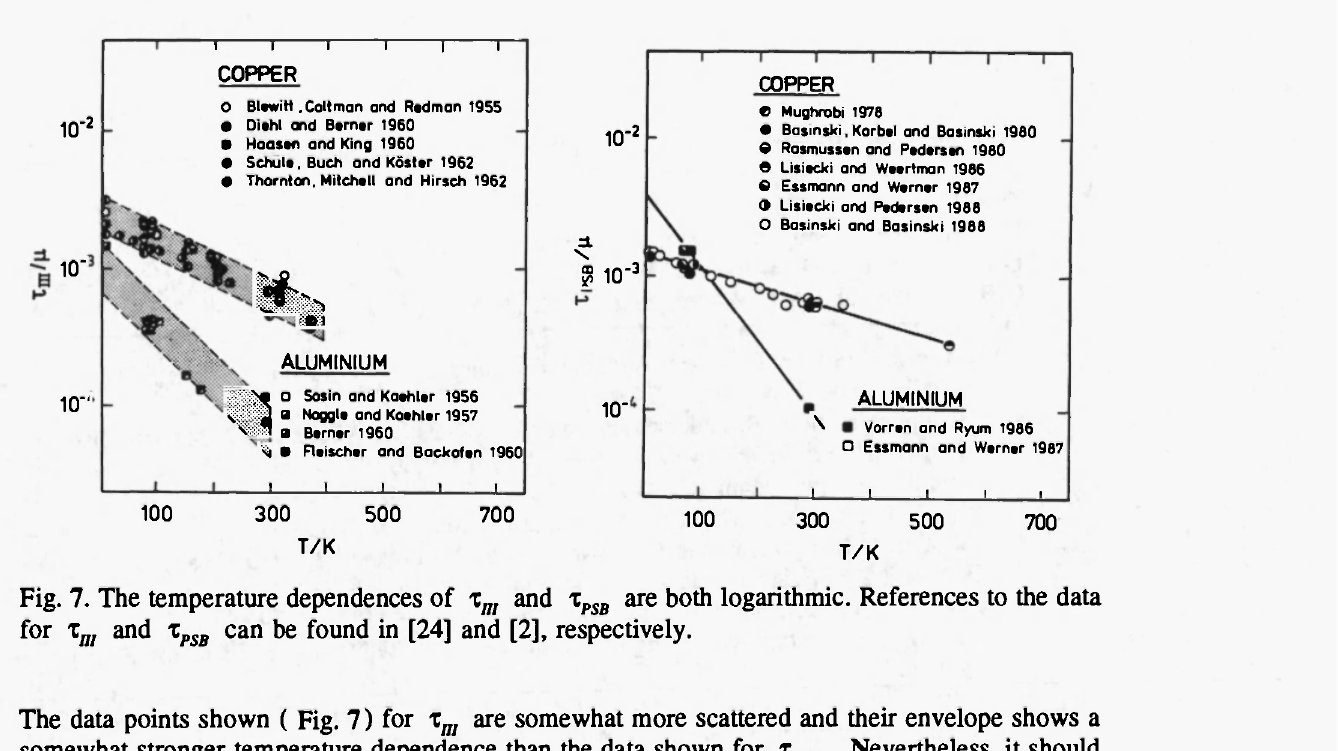
and x are both logarithmic. References to the data m PSB